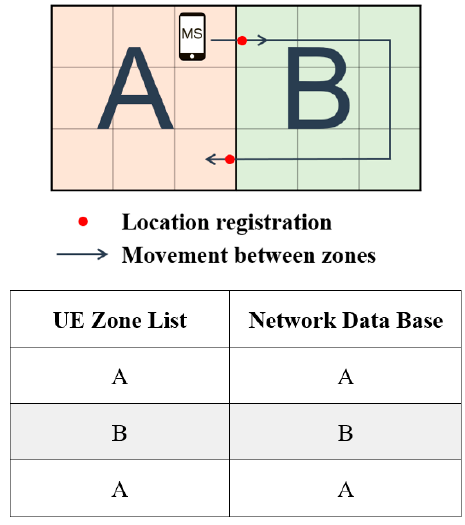
Figure 1. Location registration in 1ZR.